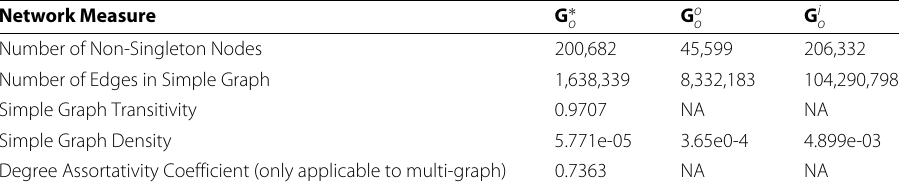
Table 7 Network measures computed for the higher-order networks ( G ∗ the text. NA means that the metric could not be computed for that network due to computational complexity or resource limitation